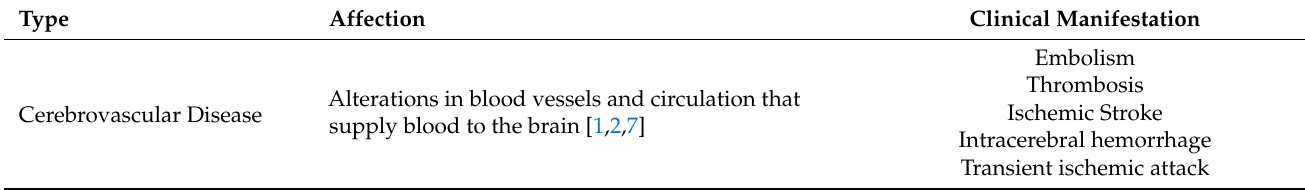
Table 1. Classification of cardiovascular diseases based on the affected organ, system, or